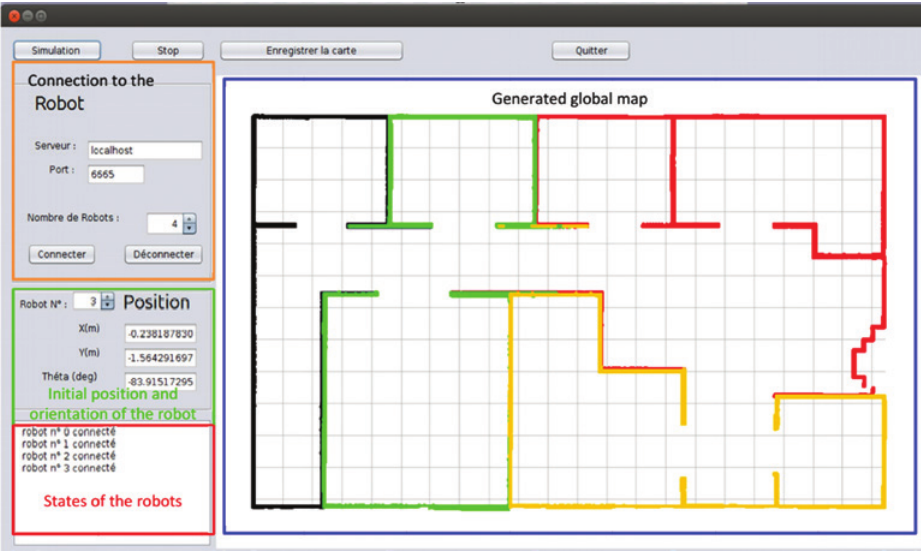
Figure 7: Developed Interface for the Collaborative Mapping of Indoor Environments. Table 1: Characteristics of the Proximity Sensor Equipping all the Robots. Range